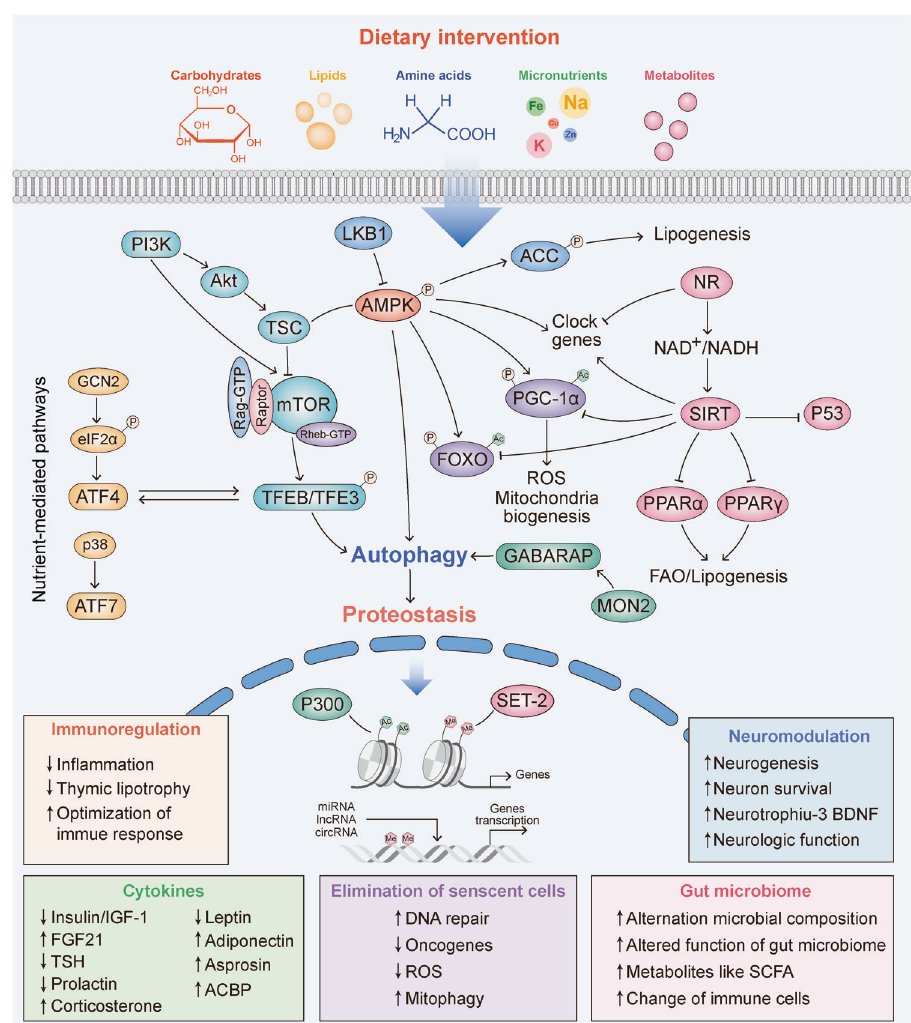
Fig. 2 Molecular and effector mechanisms of dietary intervention. Dietary intervention engages by alterable consumption of numerous nutrients, including carbohydrates, lipids, amino acids, micronutrients, and metabolites. Nutrient signals under diverse dietary interventions lead to activation of multiple biochemical pathways. As a result, these pathways involve in downstream effectors like cytokines secretion, immunoregulation, gut microbiome homoeostasis, elimination of senescent cells, and